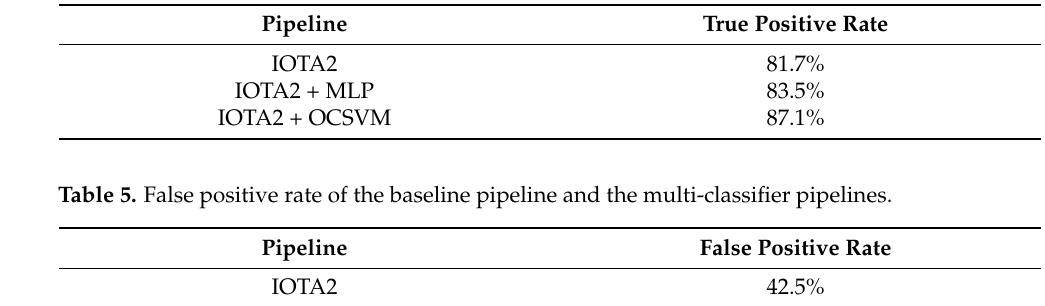
Table 4. True positive rate of the three pipelines.